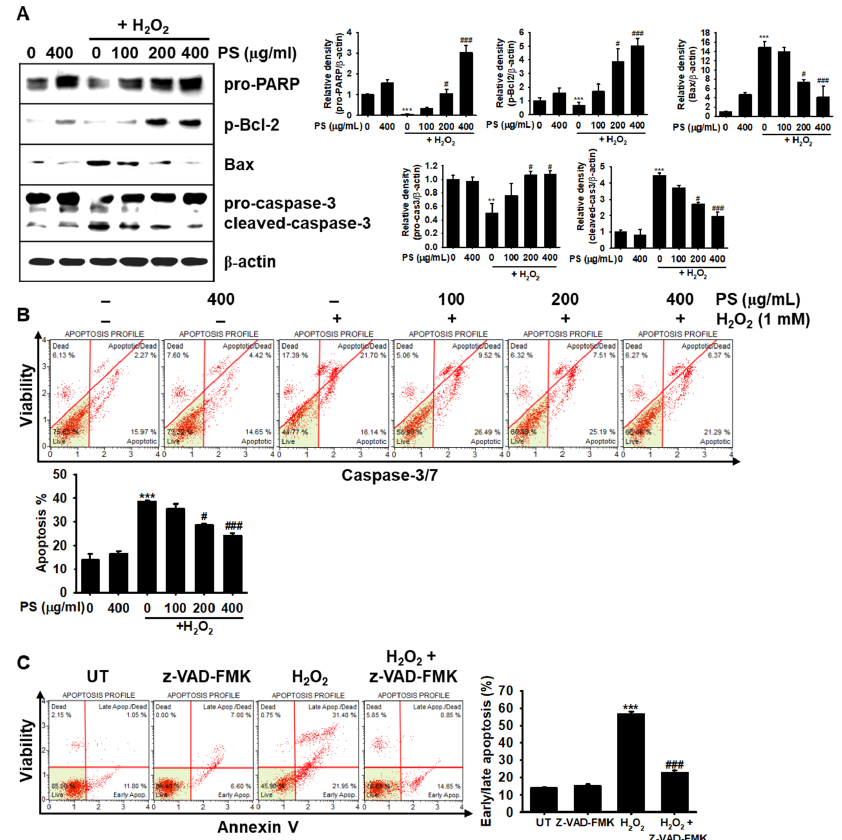
Figure 3. PS protects HaCaT keratinocytes against H 2 O 2 -mediated apoptosis by modulating apoptosis-related proteins. HaCaT keratinocytes were seeded at a density of 1 × 10 4 cells/mL